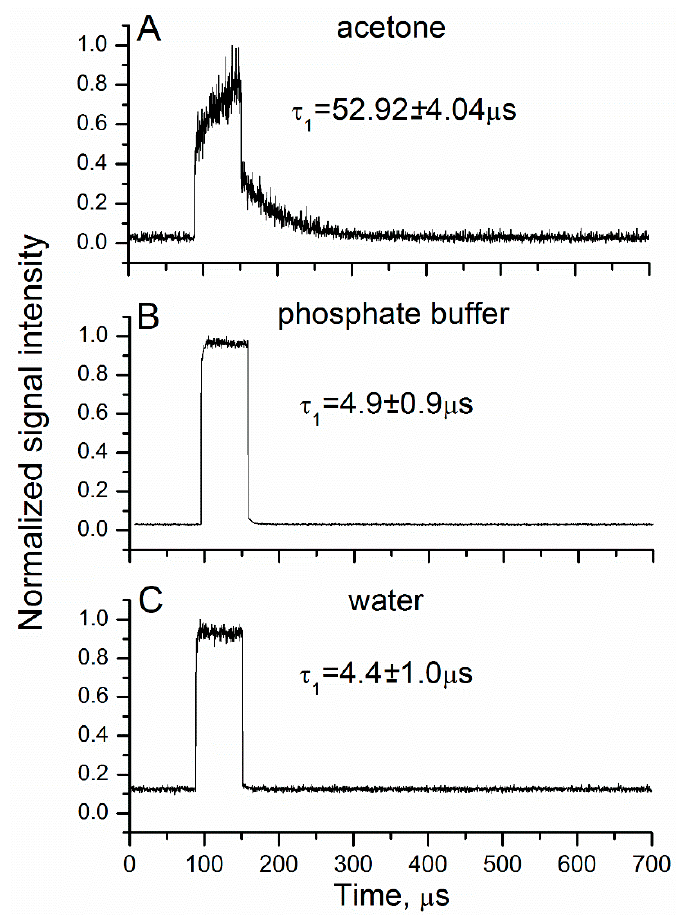
Figure 1. Comparison of phosphorescence intensity of 1 O 2 in various solvents in a photosensitizer (aluminum phthalocyanine chloride ( A ) and aluminum phthalocyanine tetrasulfonic chloride (AlPcS 4 ) ( B , C )), concentration 4·10 − 6 M.